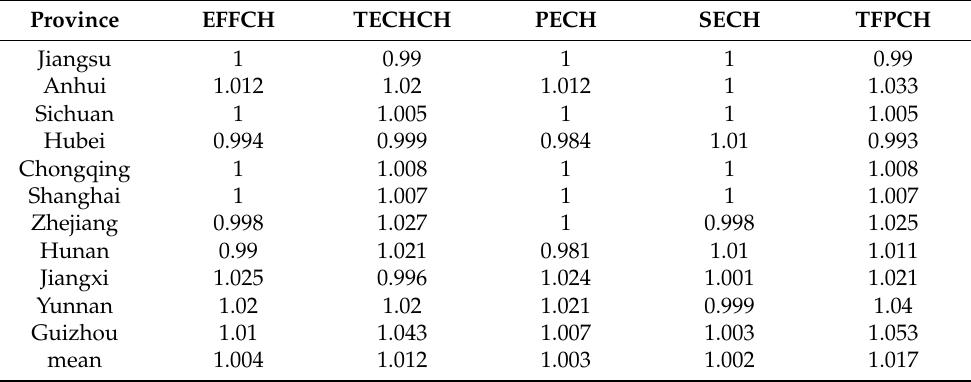
Table 3. Same as Table 2, but for unadjusted